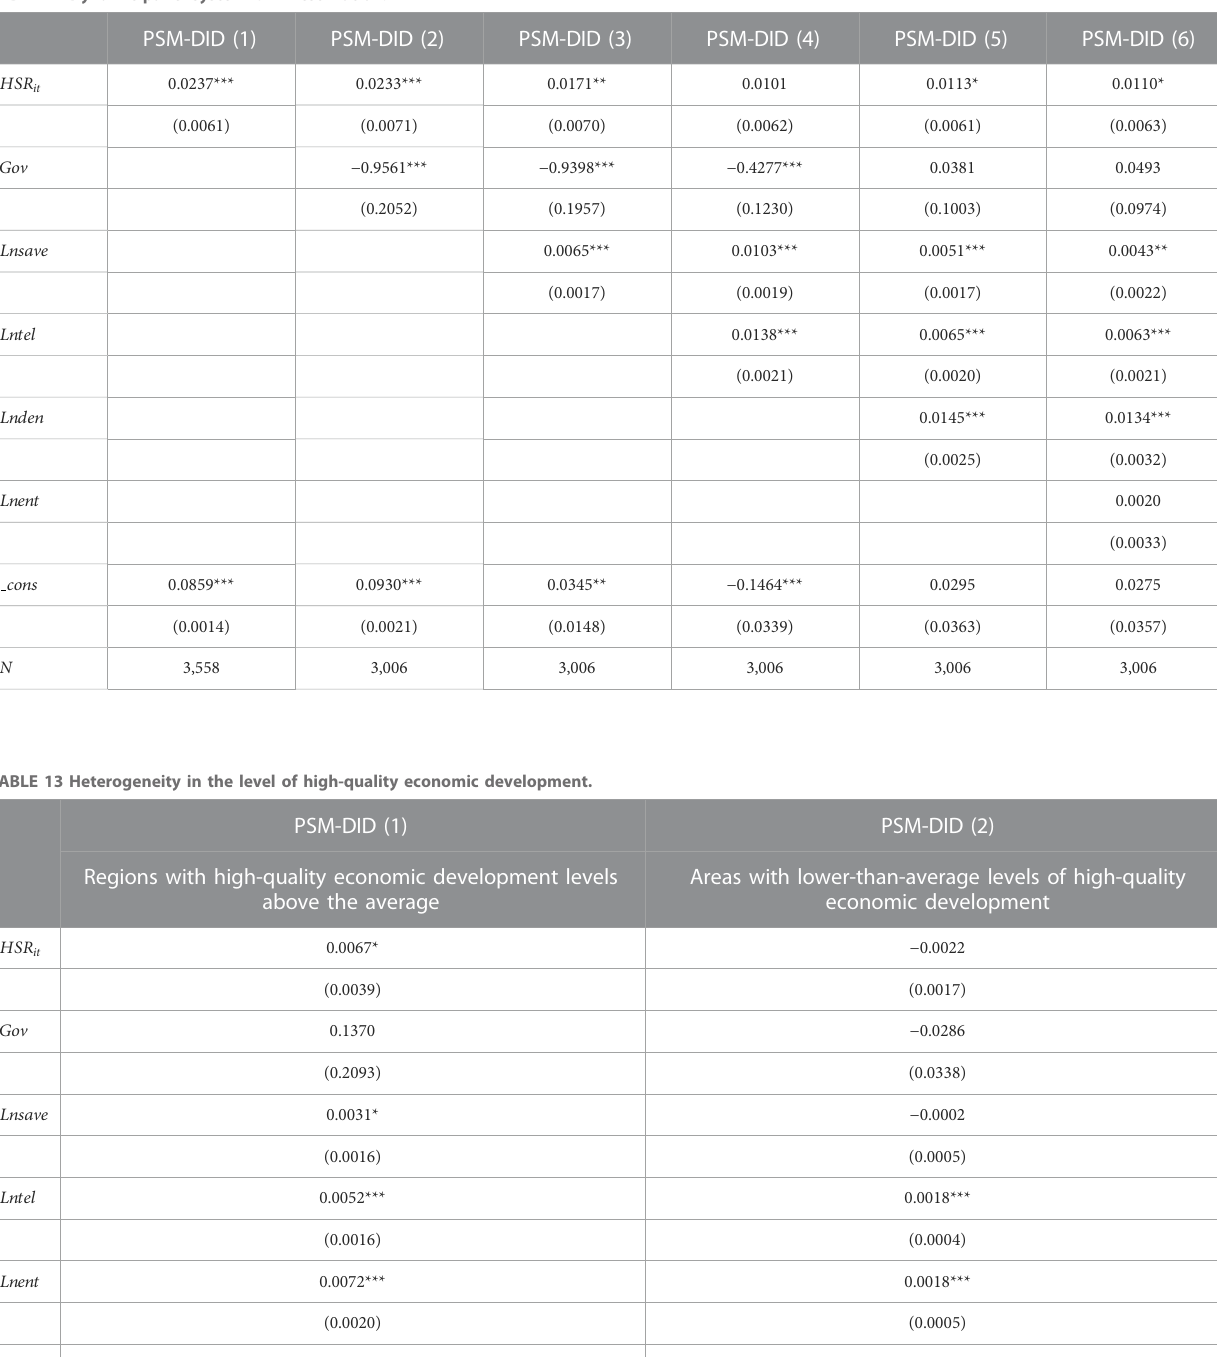
TABLE 12 Dynamic panel system GMM estimation.